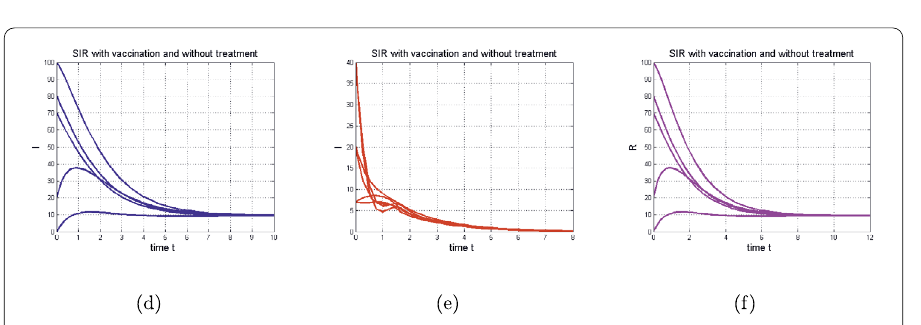
Figure 3 The time series of model (3) in the special case (12), with Figures ( d ), ( e ), and ( f ) representing (respectively) S ( t ), I ( t ), and R ( t ). The parameters of the model are b = 10, μ = 0.65, β = 0.2, c = 0.77, γ = 0.75,